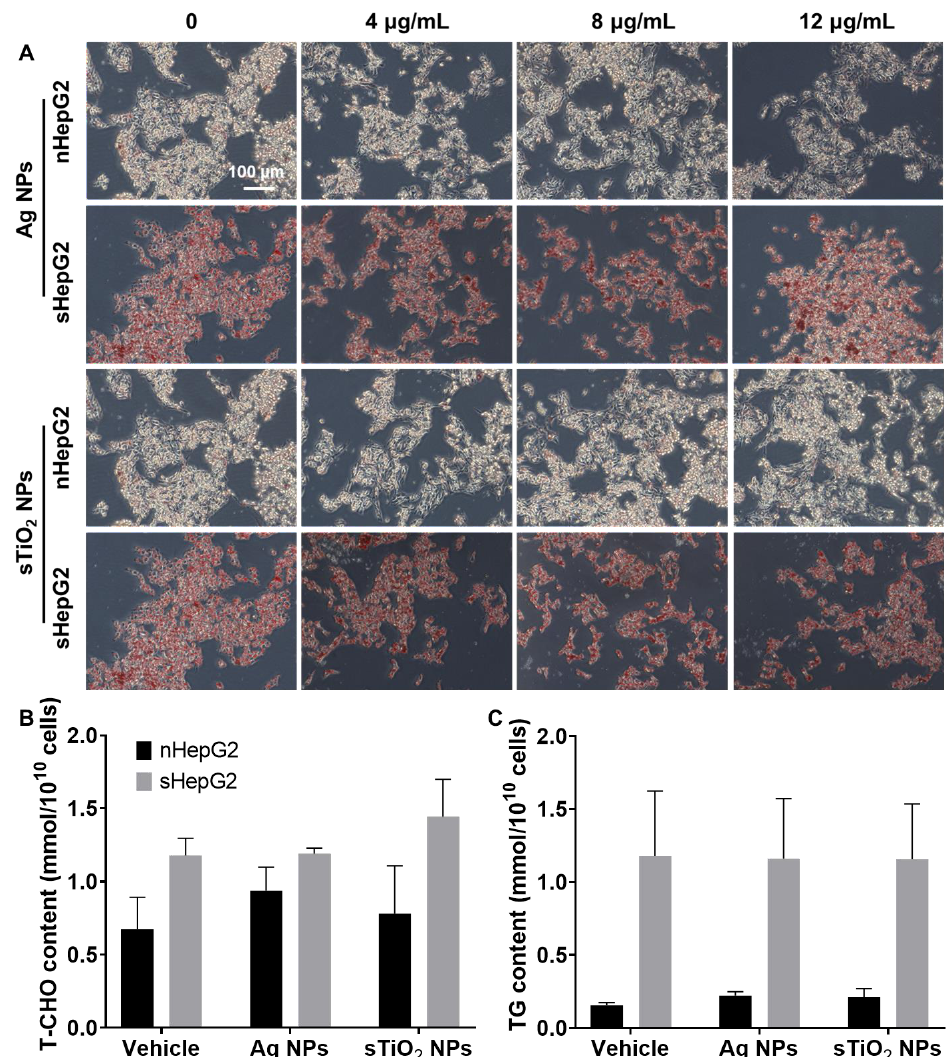
Figure 5. Qualitative and quantitative characterization of intracellular lipids in nHepG2 and sHepG2 cells after various treatments. ( A ) Micrograph of nHepG2 and sHepG2 cells with oil red O staining after 24 h treatments with Ag NPs or sTiO 2 NPs. ( B , C ) Intracellular total cholesterol (T-CHO, ( B )) and triacylglycerol (TG, ( C )) contents in nHepG2 and sHepG2 cells treated with 4 μg/mL Ag NPs or sTiO 2 NPs. In ( B , C ), data are shown as means ± s.d., n = 3.